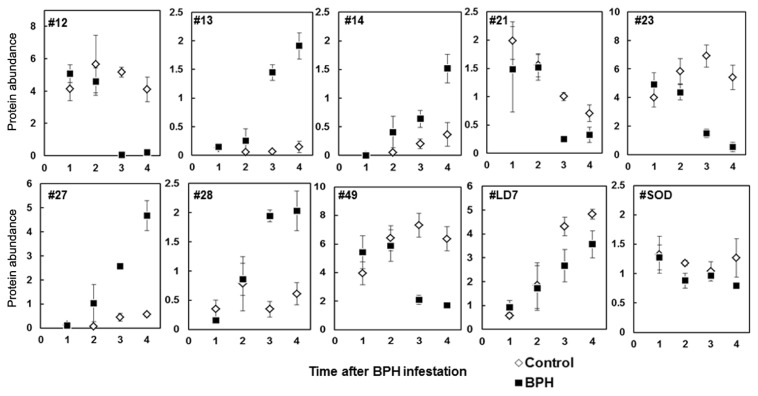
Relative protein abundance of brown planthopper (N. lugens) altered stress- and defense-related proteins in BPH infested and control IR64 at different days after infestation (DAI) (T1 = 2 DAI; T2 = 13 DAI; T3 = 28 DAI; T4 = 34 DAI). The protein abundance was quantified with Melanie3 software. Mixed models ANOVA was used for repeated measures analysis of proteins. Mean ± SE (n = 3).